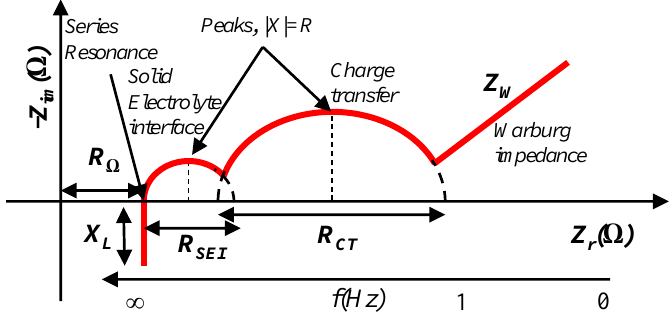
Figure 7. Properties of an impedance plot for a battery